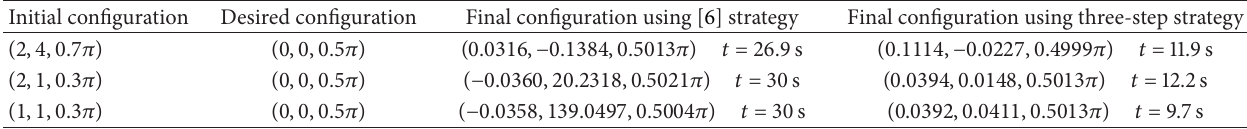
Table 1: Simulation results of final configuration.